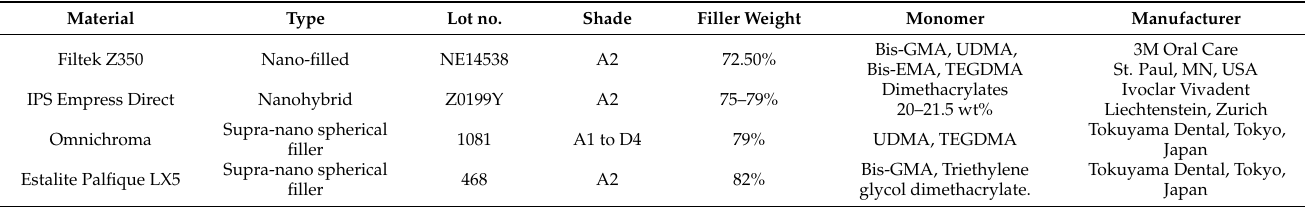
Table 1. Description of dental composite materials